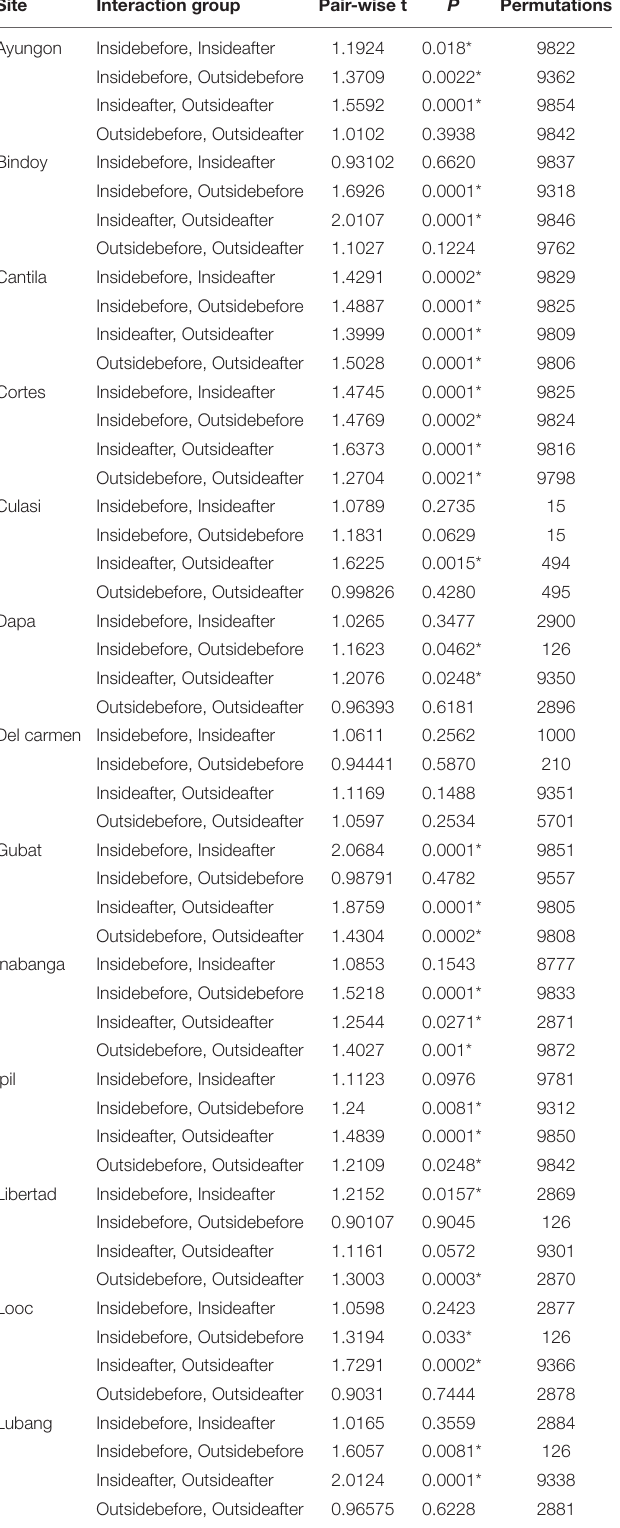
TABLE 2 | Results from PERMANOVA pair-wise test at each site for each combination factor. Site Interaction group Pair-wise t